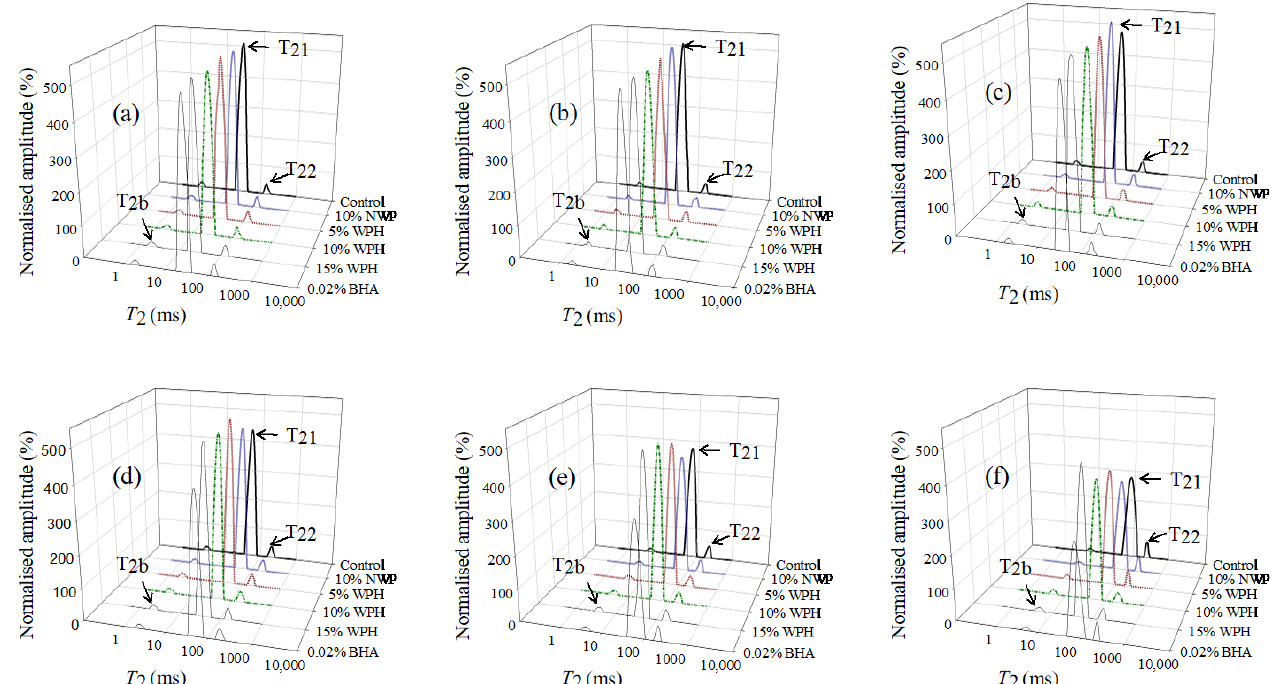
Figure 8. Distribution of the low-field NMR T 2 relaxation times of multiple freeze–thaw (F–T) cycles of pork patties with different whey protein hydrolysates (WPH) contents. ( a – f ): 0, 1, 3, 5, 7, 9 F – T cycles. Control: without any additives in the sample; NWP: native whey protein; BHA: butylated hydroxyanisole. T 2b : bound water; T 21 : immobilized water; T 22 : free water.